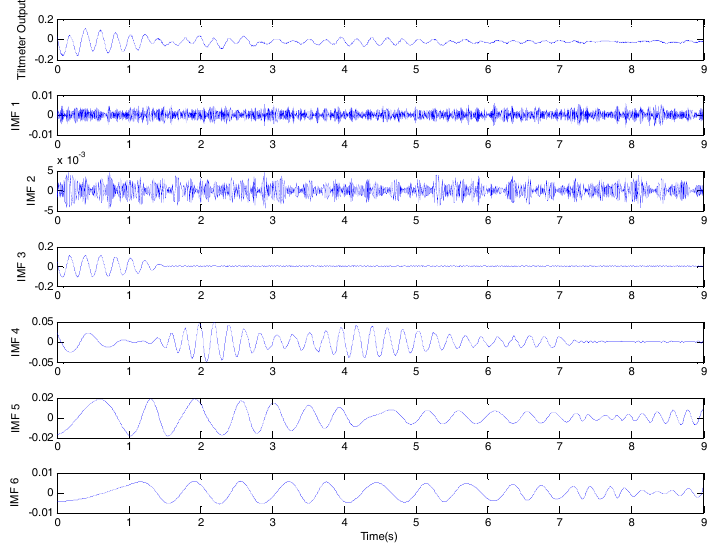
Figure 10. Decomposed components of the tiltmeter 1 reading by using a modified empirical mode decomposition (EMD) method.